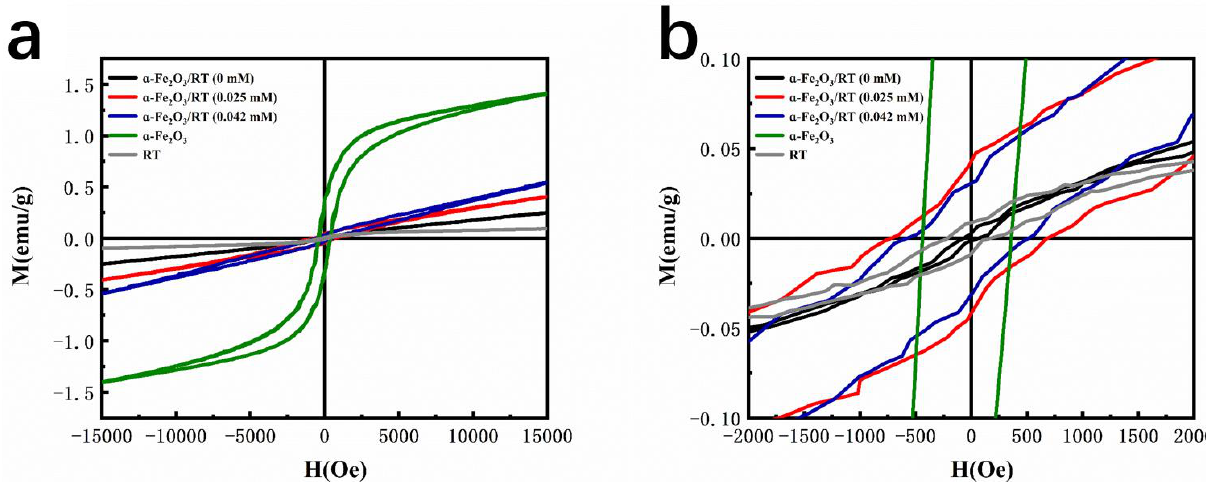
Figure 8. ( a ) Room temperature magnetization loops for the as-obtained samples: α -Fe 2 O 3 /RT (0 mM), α -Fe 2 O 3 /RT (0.025 mM), α -Fe 2 O 3 /RT (0.042 mM), α -Fe 2 O 3 , and RT and ( b ) enlarged view of magnetization loops.